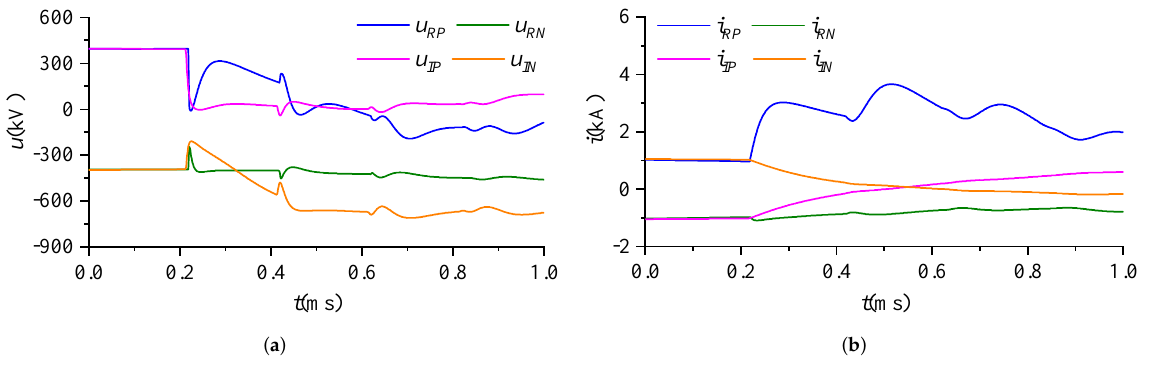
Figure 7. VTWs and CTWs of both terminals with internal fault (F1). ( a ) VTWs of both terminals. ( b ) CTWs of both